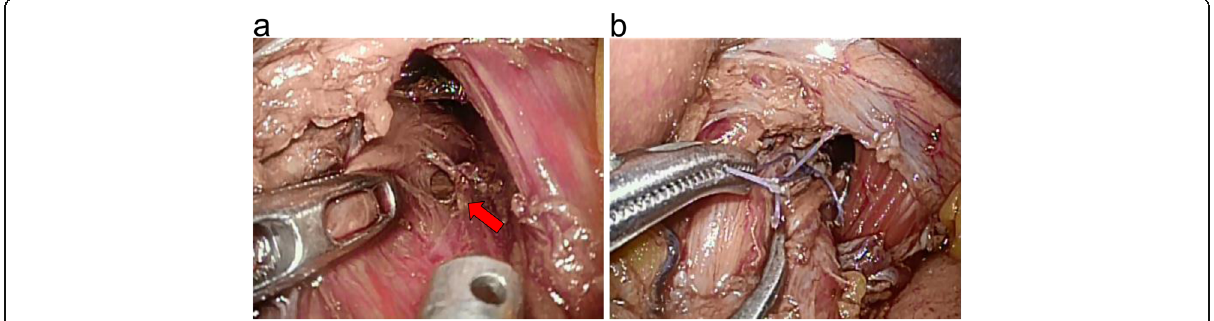
Fig. 3 Intraoperative view. a Red arrow shows the site of perforation. b The rupture site was successfully closed with simple sutures